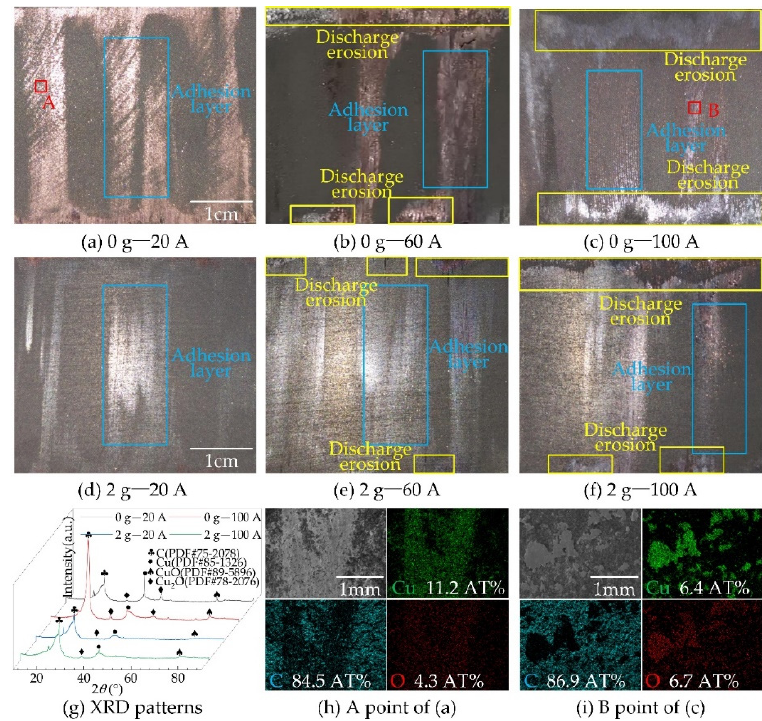
Figure 8. Surface morphology and composition of carbon sliders at 0–2 g water content: ( a – c ) surface morphology under different currents at 0 g water content; ( d – f ) surface morphology under different currents at 2 g water content; ( g ) XRD patterns; ( h , i ) EDS composition distribution of ( a , c ). Point A is the region of 0 g-20 A carbon slider surface scanned by EDS. Point B is the region of 0 g-100 A carbon slider surface scanned by EDS.